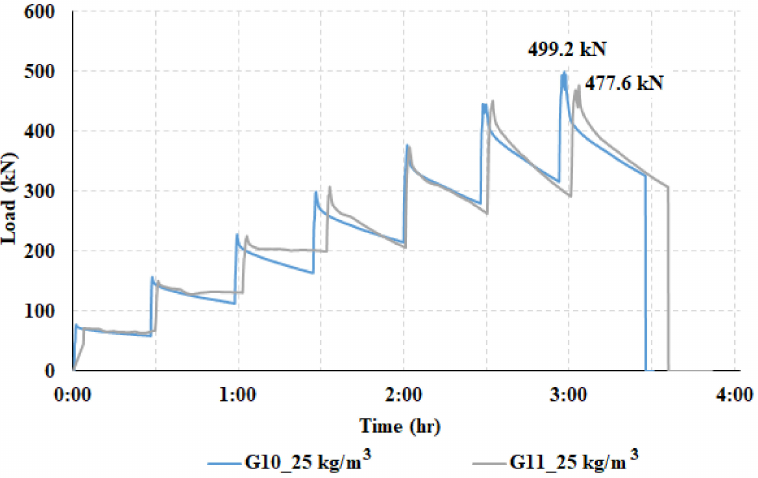
Figure 12. Loading in steps of the centrically loaded slab (G10) and eccentrically loaded slab (G11).